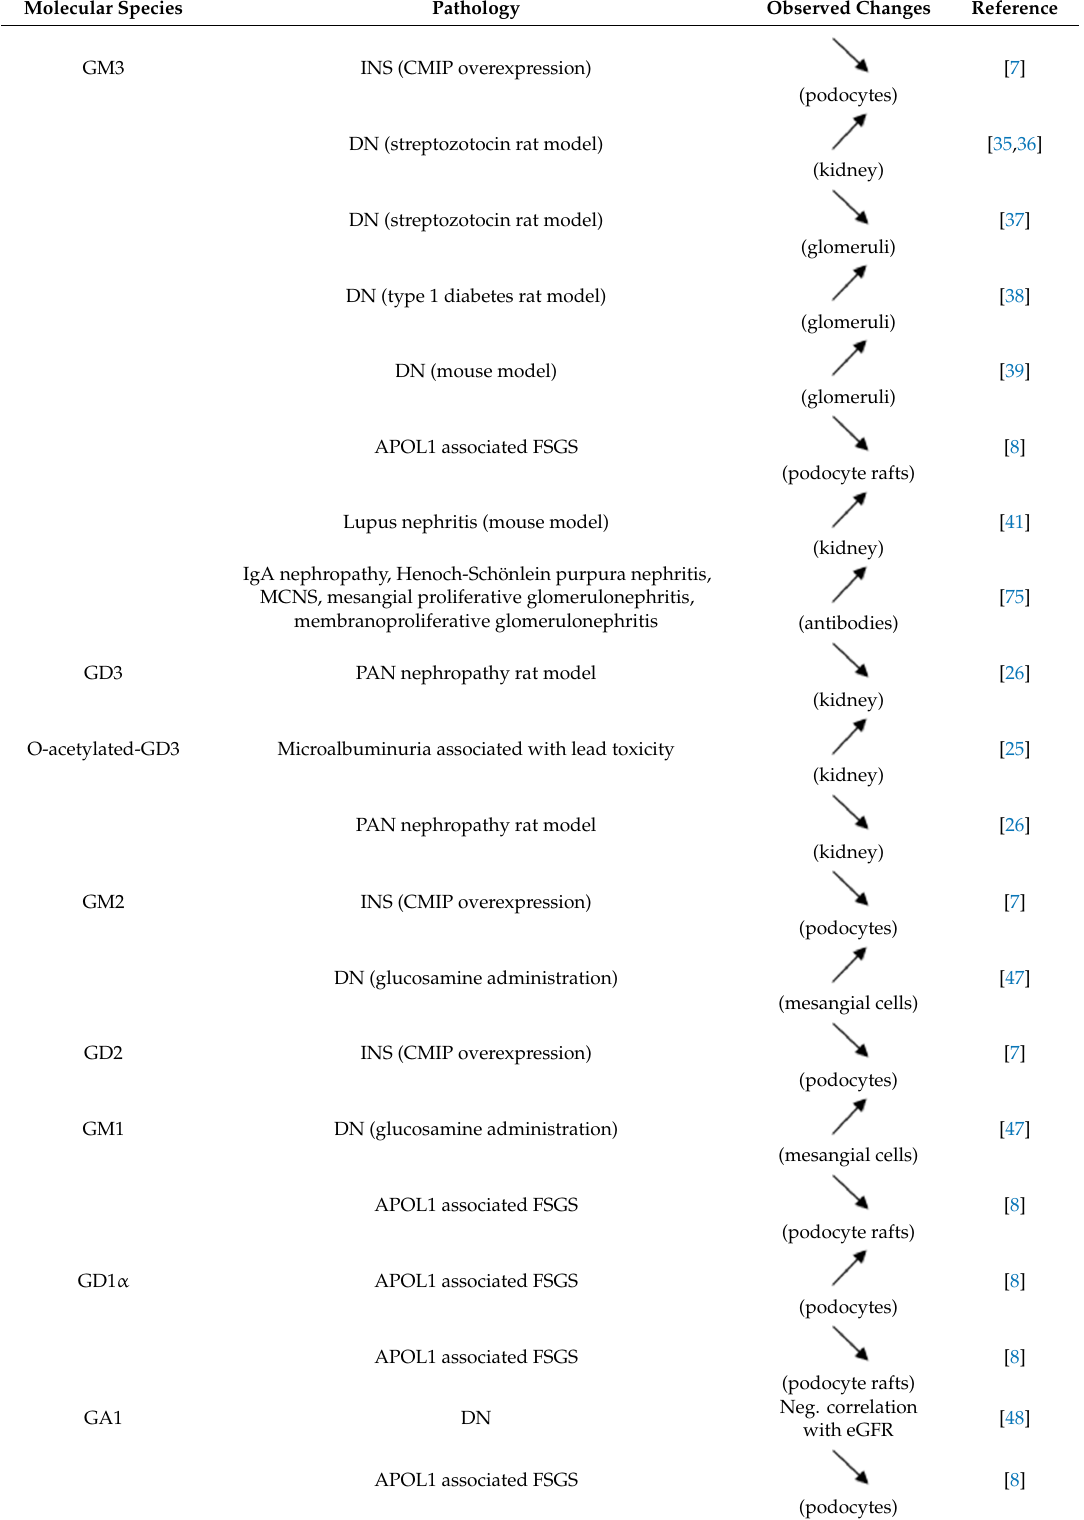
Table 1. Changes in the abundance of gangliosides and precursors associated with glomerular diseases.